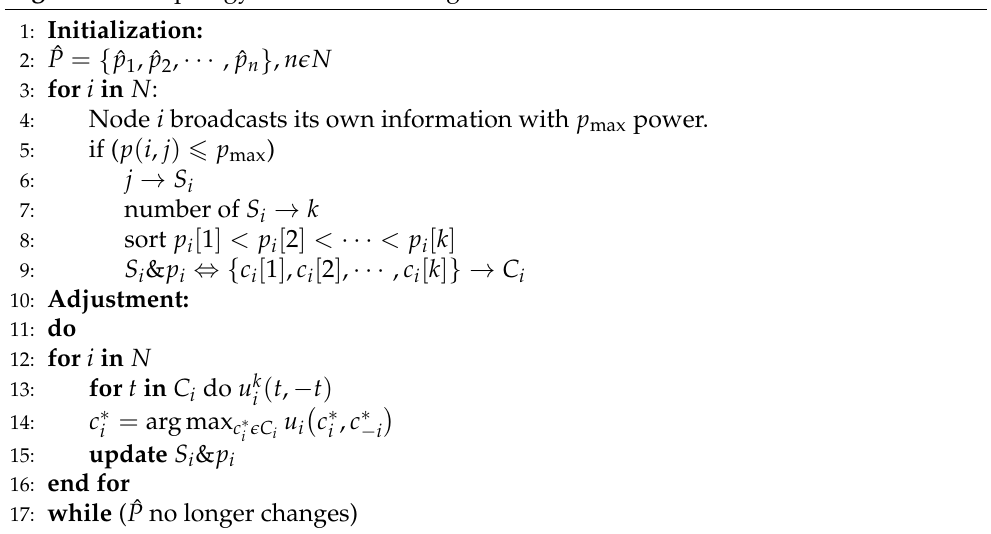
Algorithm 1 Topology Control Game Algorithm.